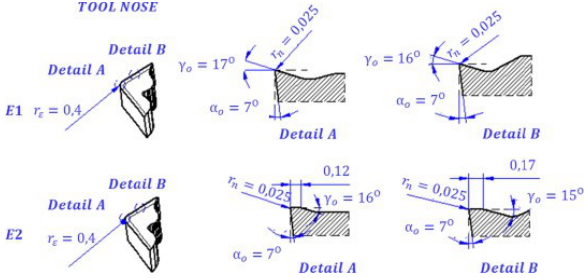
Figure 10: Effect of cutting speed on cutting force [35]